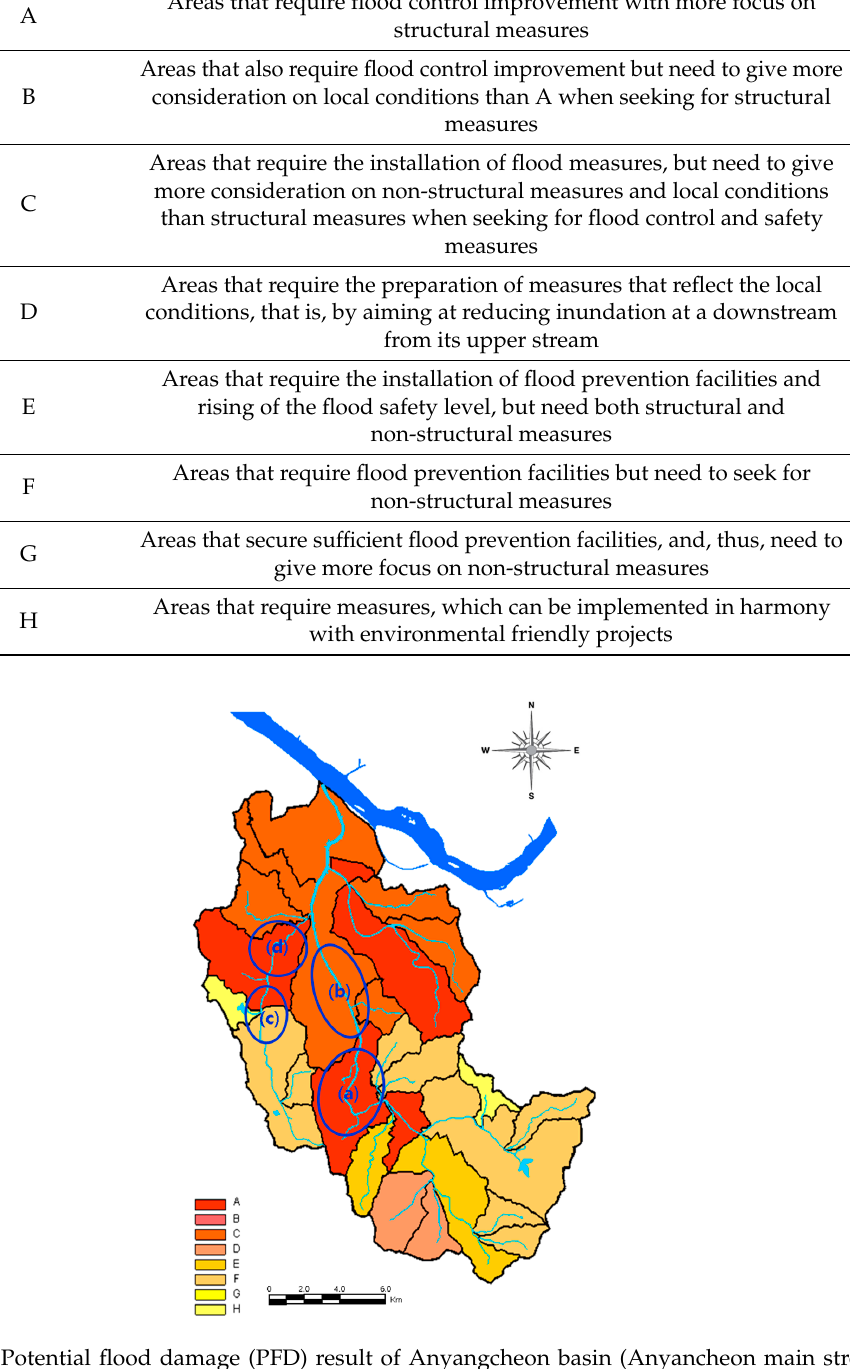
Table 4. Construction cost, benefit, and Benefit/Cost (B/C) of feasible flood measures.